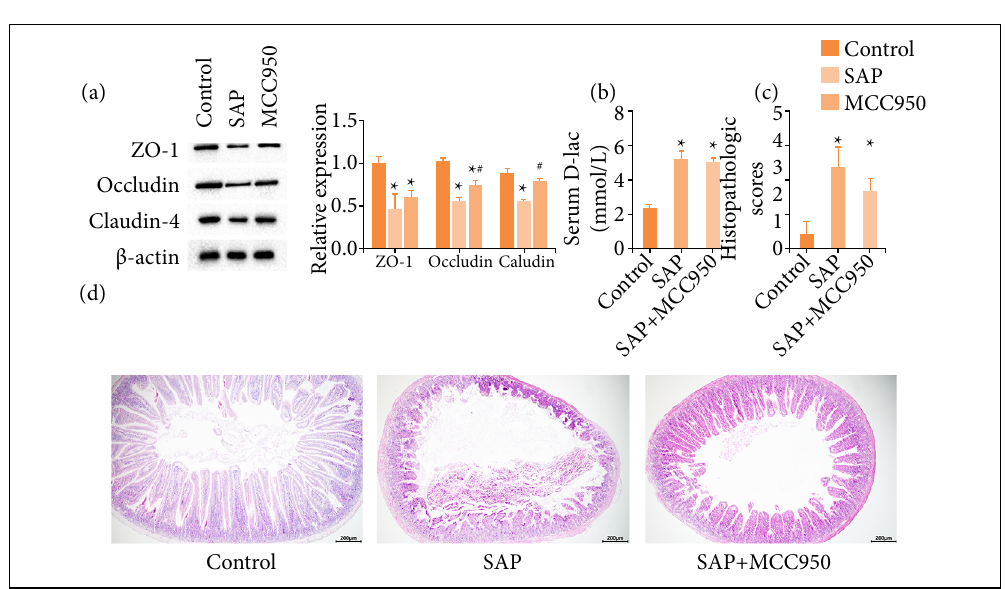
Figure 4 - Protective effect of MCC950 on intestinal injury in acute pancreatitis mice. (a) Intestinal tight junction protein; (b) Serum D-lactic acid; (c) Pathological injury score of small intestine; (d) HE staining of small intestine (1:100). N = 6; * p < 0.05 vs. control; # p < 0.05 vs.